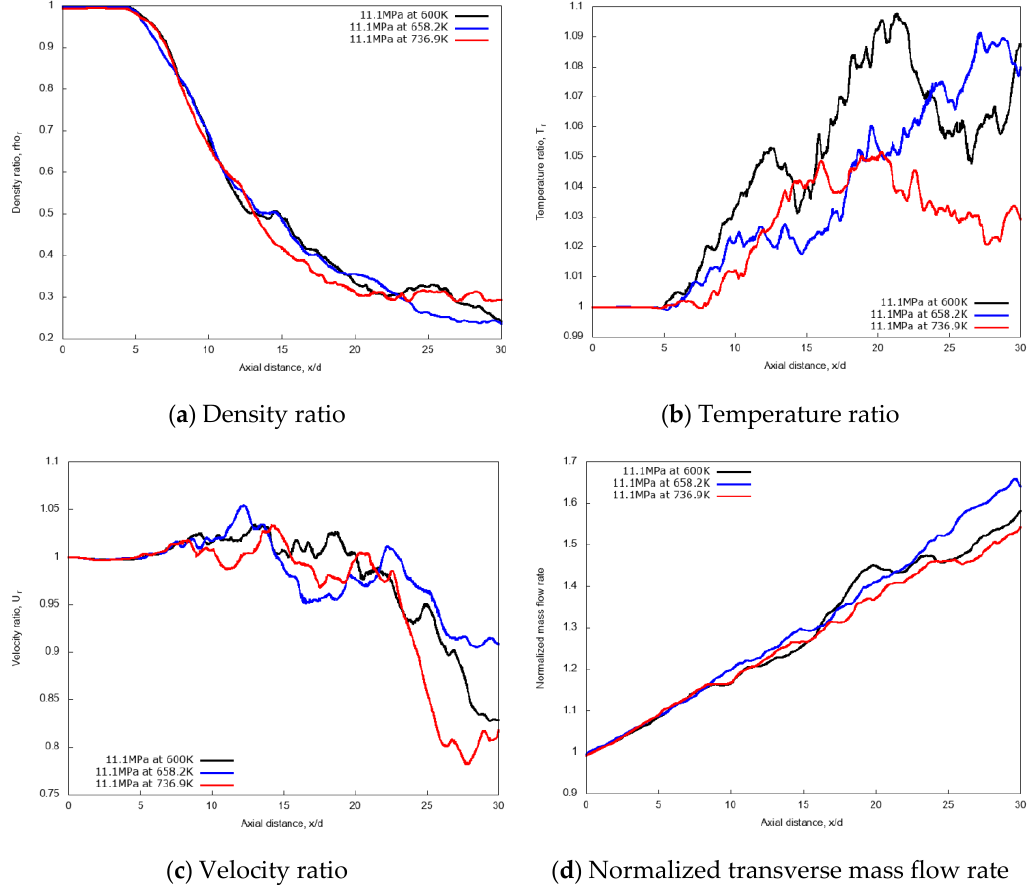
Figure 12. Centerline axial profiles of non-dimensional density, temperature, velocity, and normalized transverse mass flow rate for different n-dodecane injection temperatures: 600 K, 658.2 K and 736.8 K. Simulations of n-dodecane injected at 200 m/s into a supercritical hot nitrogen, 972.9 K and 11.1 MPa.